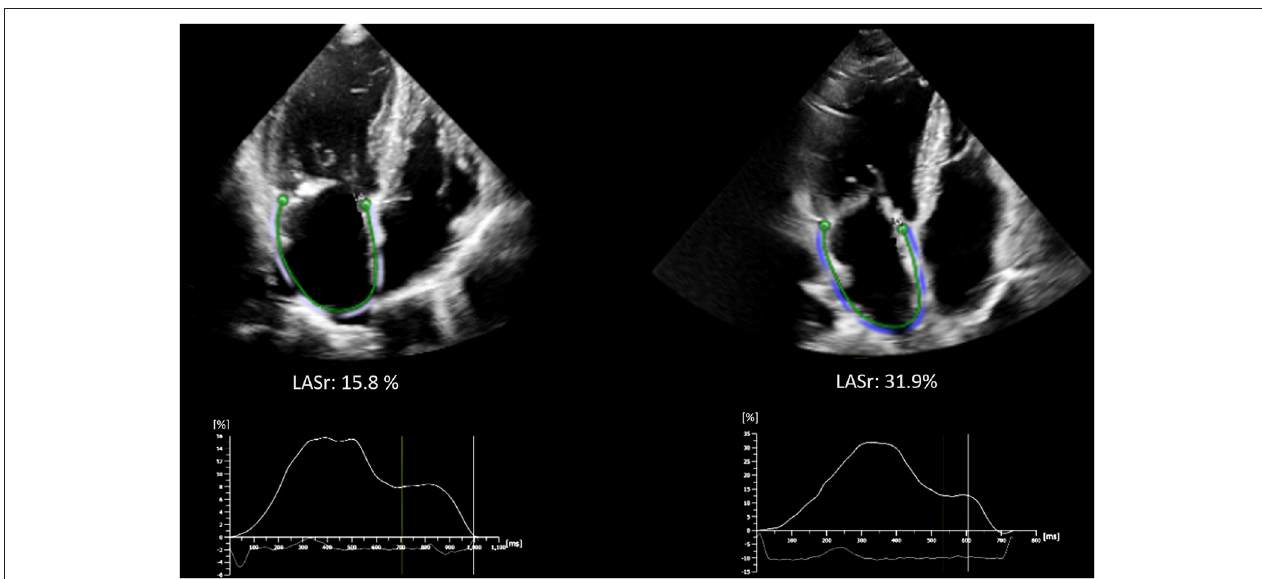
FIGURE 3 | Representative images of LA strain assessment of patients with baseline LASr < 20% (left side, LASr = 15.8 %) and ≥ 20% (right side, LASr = 31.9%). Strain curves are depicted below the echocardiographic images. LA, Left atrium; LASr, Left atrial peak reservoir